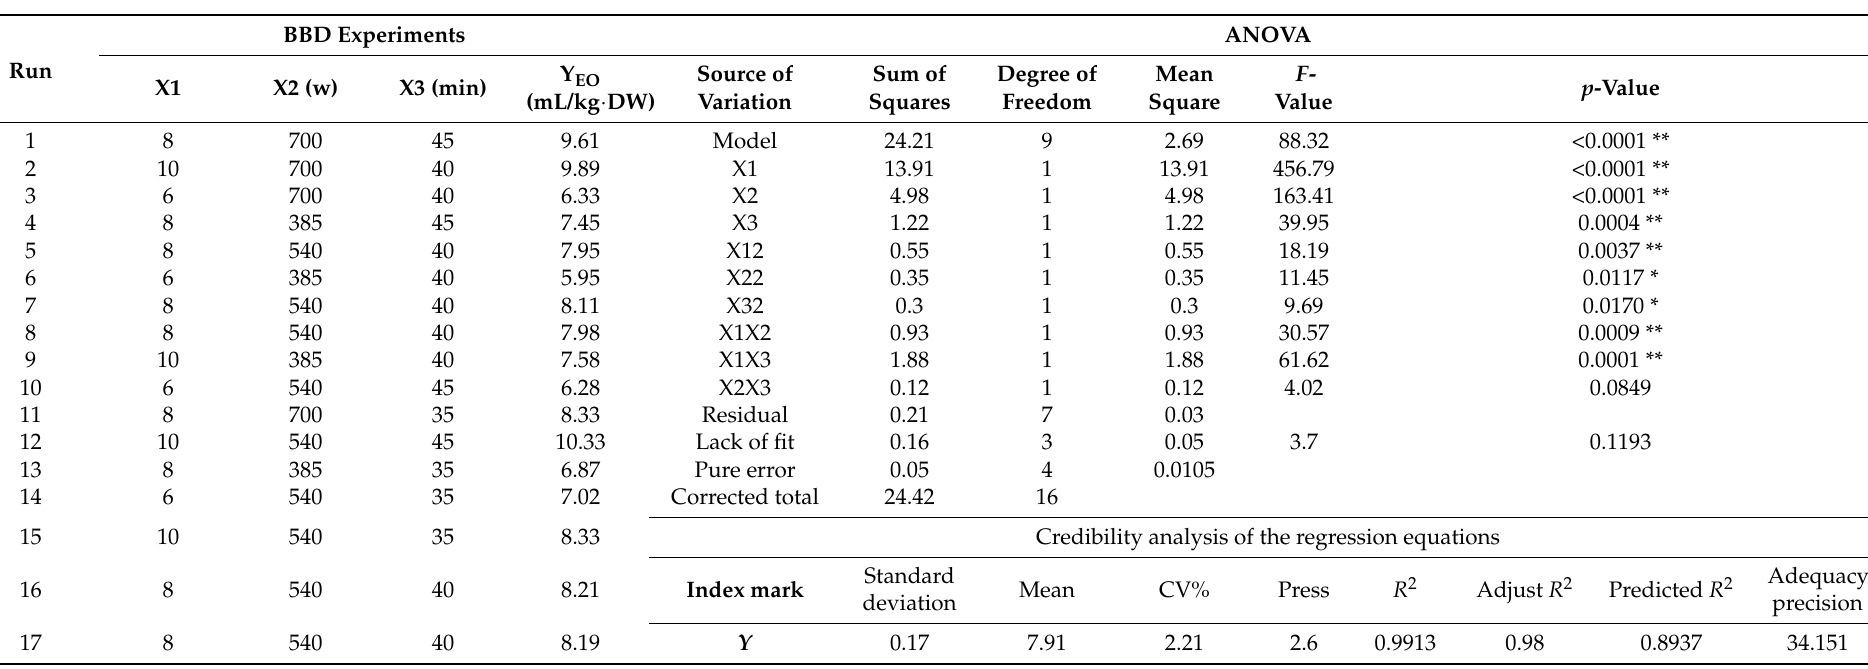
Table 1. Box-Behnken design (BBD) with experimental value for a total yield of EO (mL/kg · DW), analysis of variance (ANOVA) for response surface quadratic model; “*”is significant and “**” is extremely